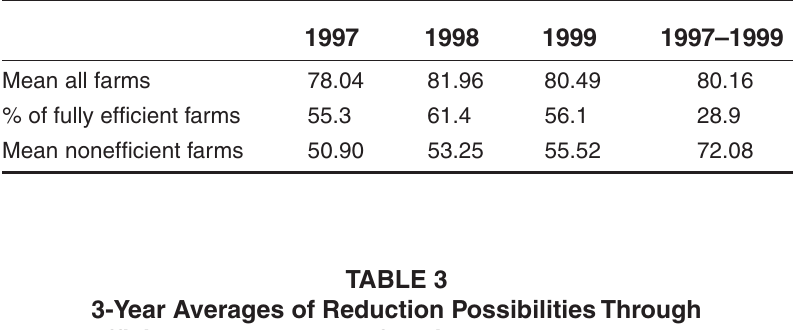
Nutrient Efficiency Scores for Separate Years and 3-Year Averages